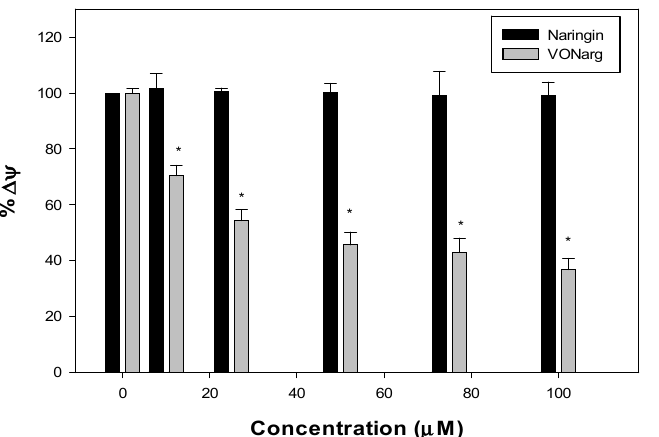
Figure 8. Changes of the mitochondrial membrane potential (% Δψ ) in A549 cells treated with increasing concentrations naringin (black) and VONarg (grey) for 24 h. Each point represents the mean ± S.E.M of three measurements in three independent experiments. Significant differences: * p < 0.05 compared to the control.